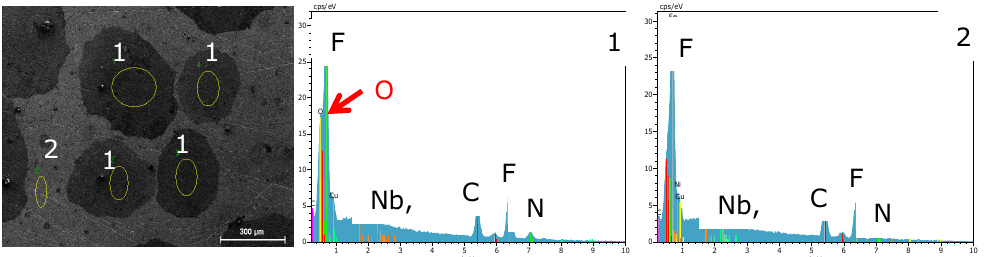
Figure 7. Scanning electron microscopy micrographs and elements distributed within the ellipsoids formed on the corroded surface of X5CrNiCuNb16-4 after hardening and tempering at 670 °C before being exposed for 8000 h at 60 °C and 100 bar to water-saturated supercritical CO 2 .